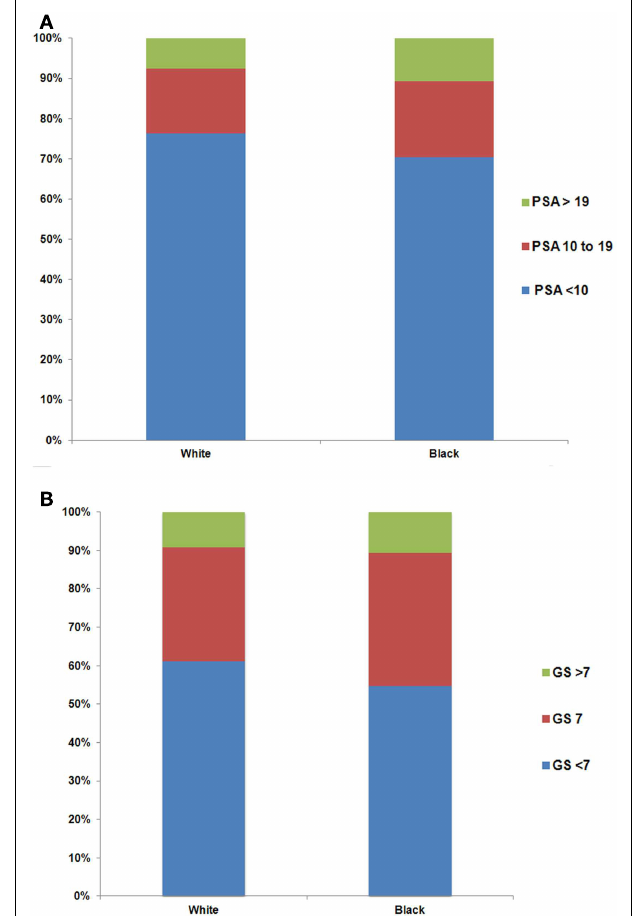
FIGURE 2 | Distribution of PSA (A) and Gleason Score (GS) (B) by white and black race among men with stageT1cN0M0 prostate cancer